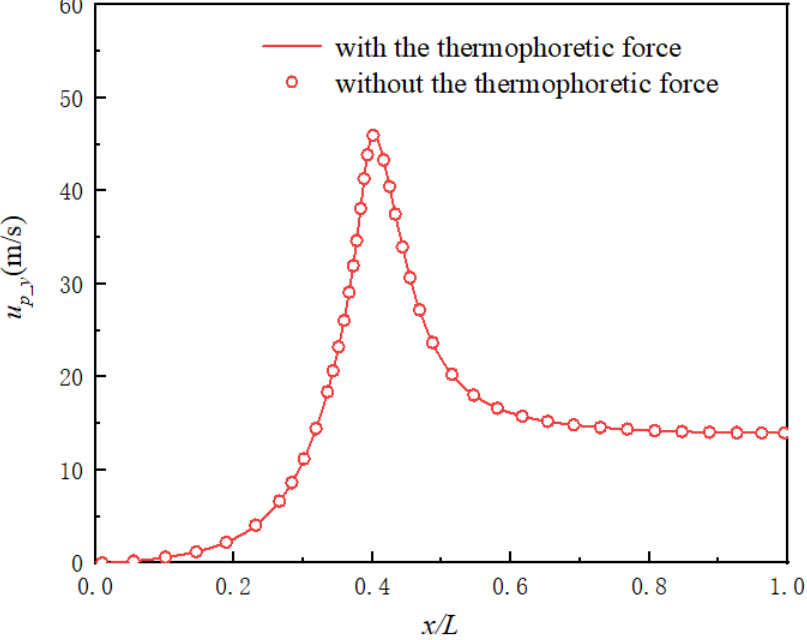
Figure 6. The change in the particle velocity in the nozzle considering the effect of the thermo- mophoretic phoretic force.